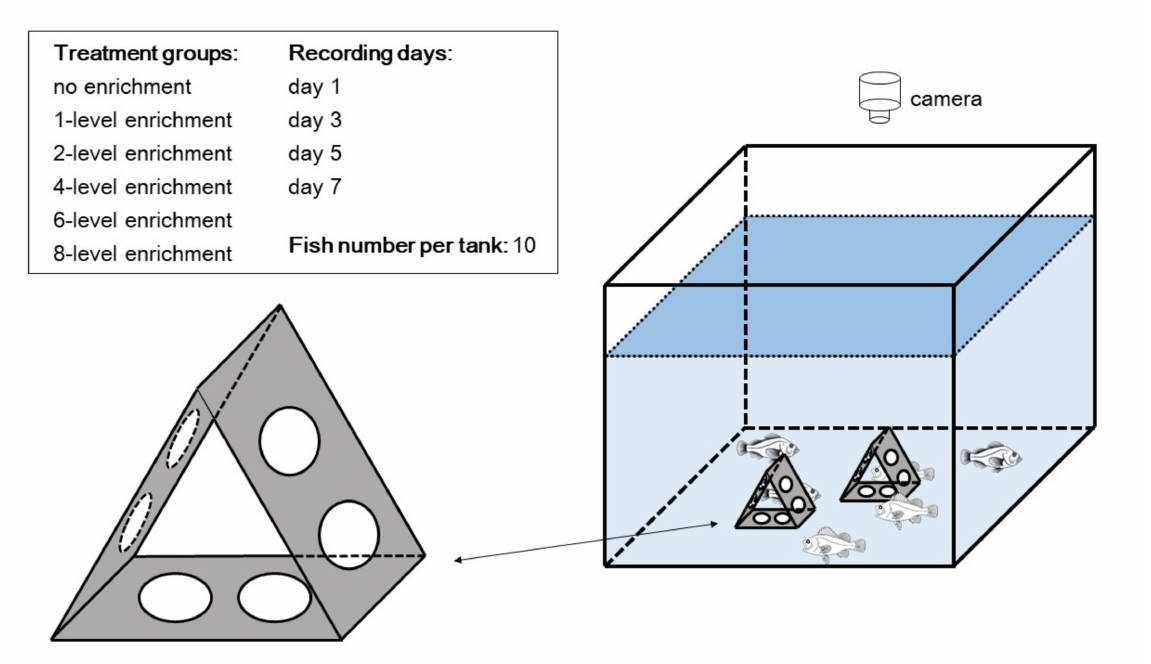
Figure 1. Sketches of overall experimental design and physical structure used for environmental enrichment. The treatment groups include different enrichment levels (i.e., intensity of enrichment; no, 1-level, 2-level, 4-level, 6-level and 8-level enrichments). This figure shows the 2-level enrichment treatment. The number of physical structures depends on the experimental